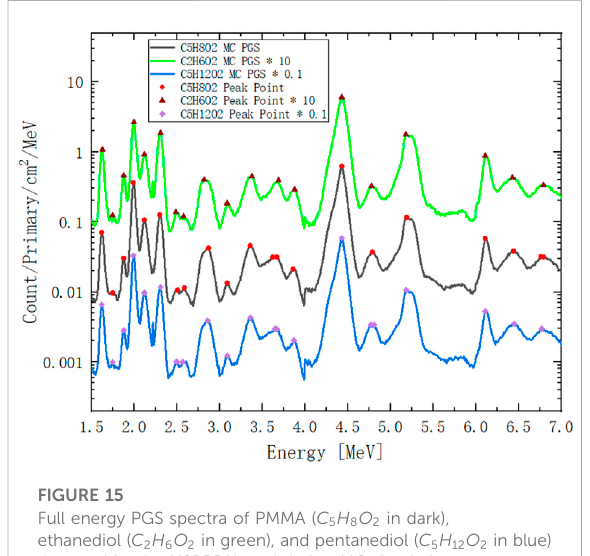
FIGURE 15 Full energy PGS spectra of PMMA ( C 5 H 8 O 2 in dark), ethanediol ( C